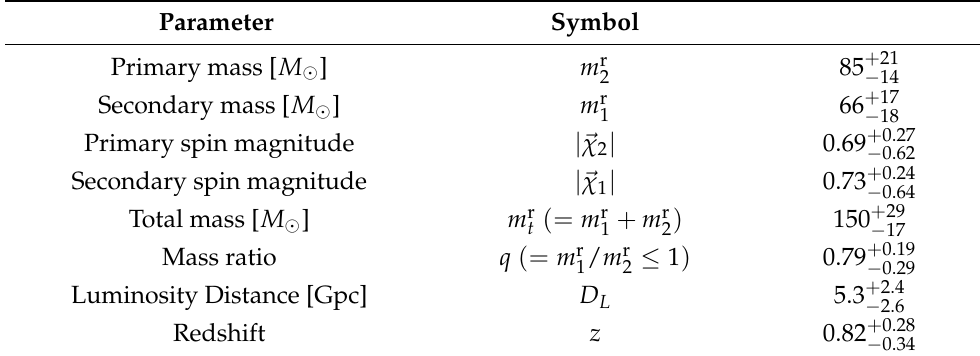
Table 1. Summary of the source parameters of GW190521 as a quasicircular BBH merger, reported by the LIGO–Virgo collaboration [3] based on the BBH waveform model [6]. The symmetric 90% credible interval for each parameter is also quoted. Note that the parameters are written in our notation and masses are given in the source’s rest frame; multiply by ( 1 + z ) to convert to the observer frame. Parameter Symbol Primary mass [ M (cid:12) ] m r Secondary mass [ M (cid:12) ] m r Primary spin magnitude | (cid:126) χ 2 | 0.69 + 0.27